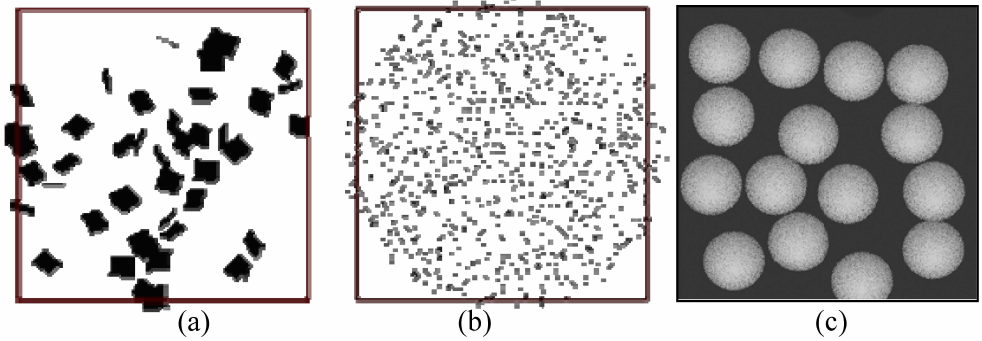
Figure 6. Projection of HOMOBJ and HETOBJ: ( a ) projecting a HOMOBJ into spatially explicit individual leaves (dark objects); ( b ) projecting a HOMOBJ into random pixels; ( c ) projecting the forest scene in Figure 3f into random pixels.